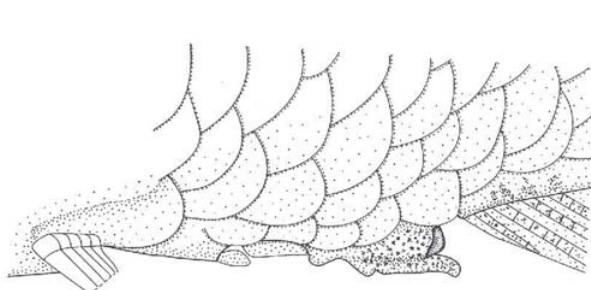
Fig. 8. Lophiobrycon weitzmani , paratype, mature female, MZUSP 83353, 18.2 mm SL; urogenital papilla of mature female, lateral view, left side, anterior at left.